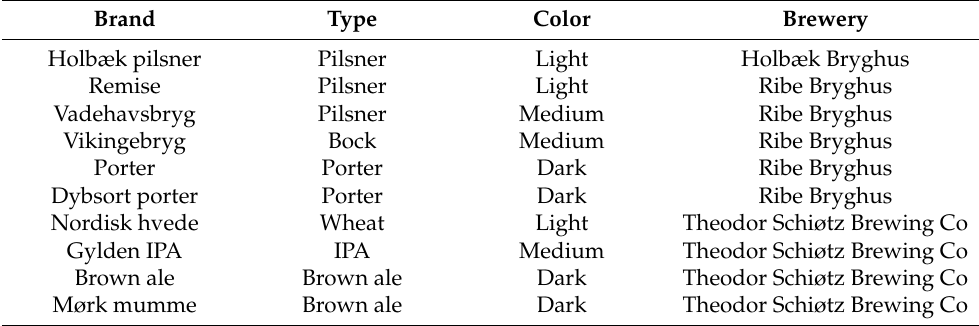
Table 1. Overview of the beers used in the